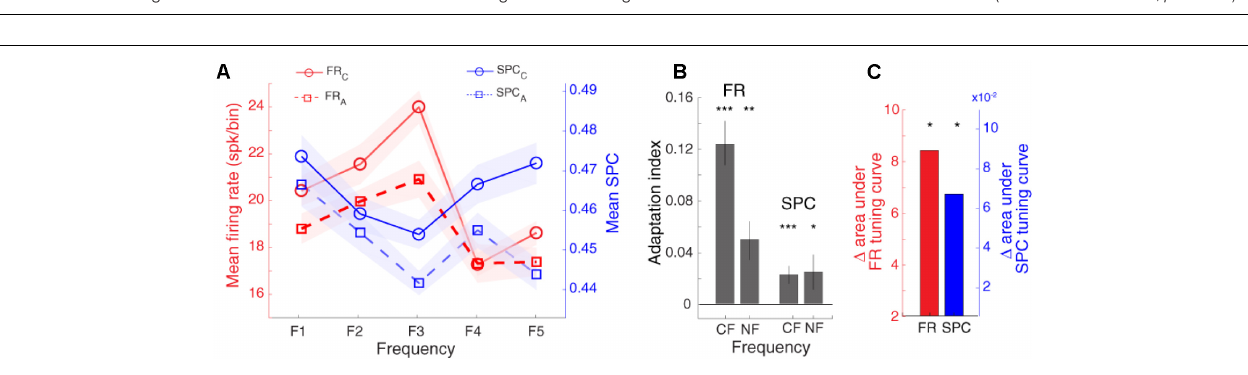
frequency (CF) and its neighboring frequencies (NF; f1, f2, f4, f5) ( Figure 5B ). Also, the (cid:49) area under tuning curve is performed using the difference between the area under control (solid) and adapting (dashed) curves in firing rate and SPC tuning curves, respectively ( Figure 5C ). As a result, the adaptation caused